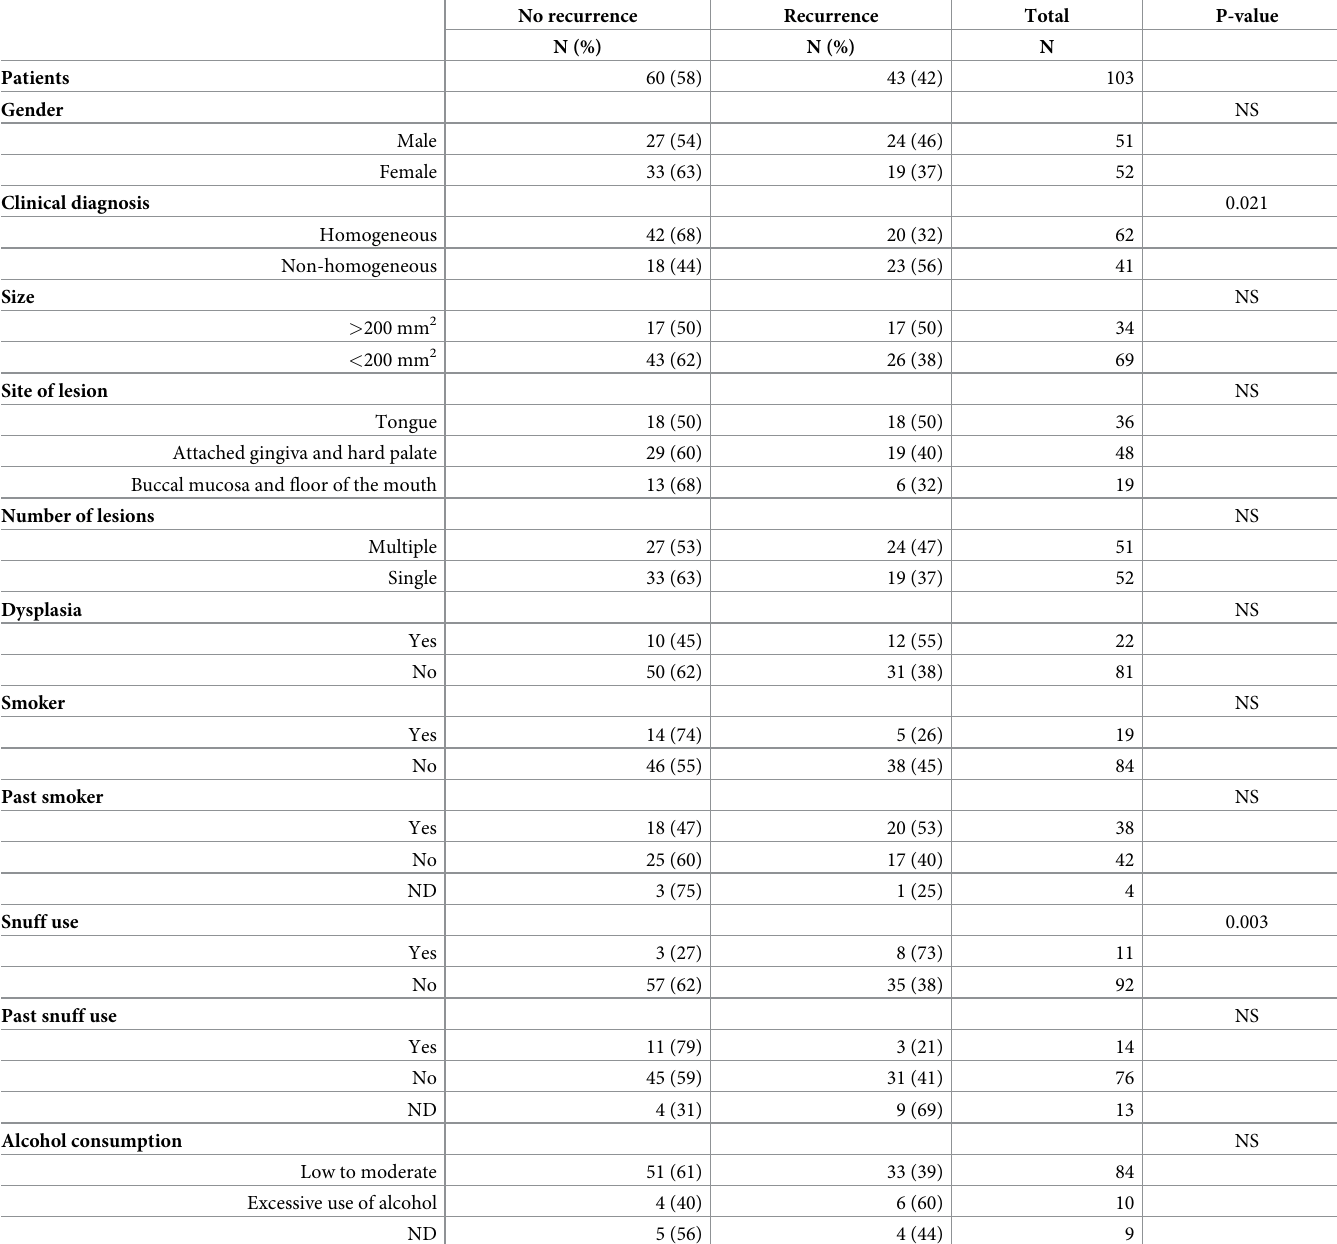
Table 2. Patients treated with surgical removal of